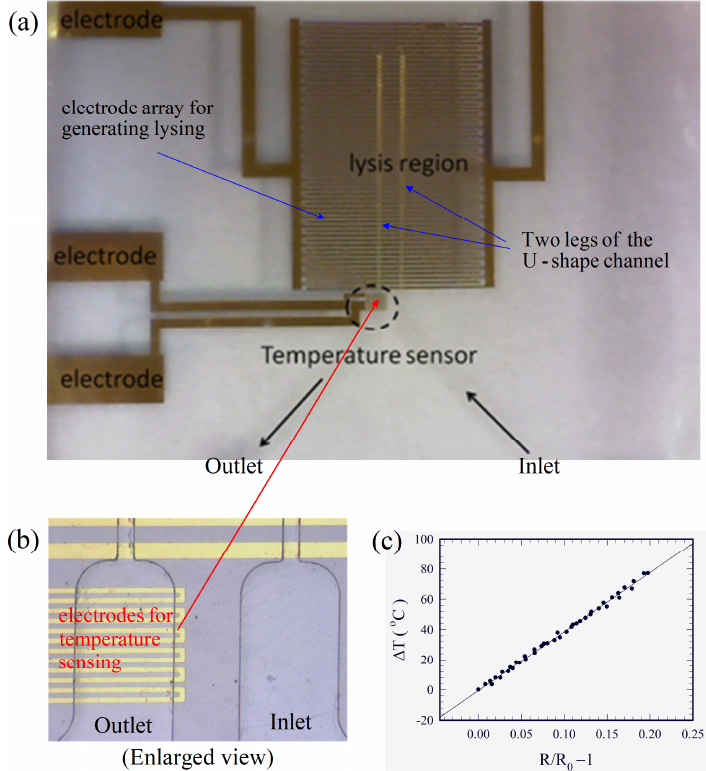
Figure 2. ( a ) The completed device for electrical lysis. ( b ) The temperature sensor built at the exit of the device. ( c ) Variation of the temperature with electric resistance for the temperature